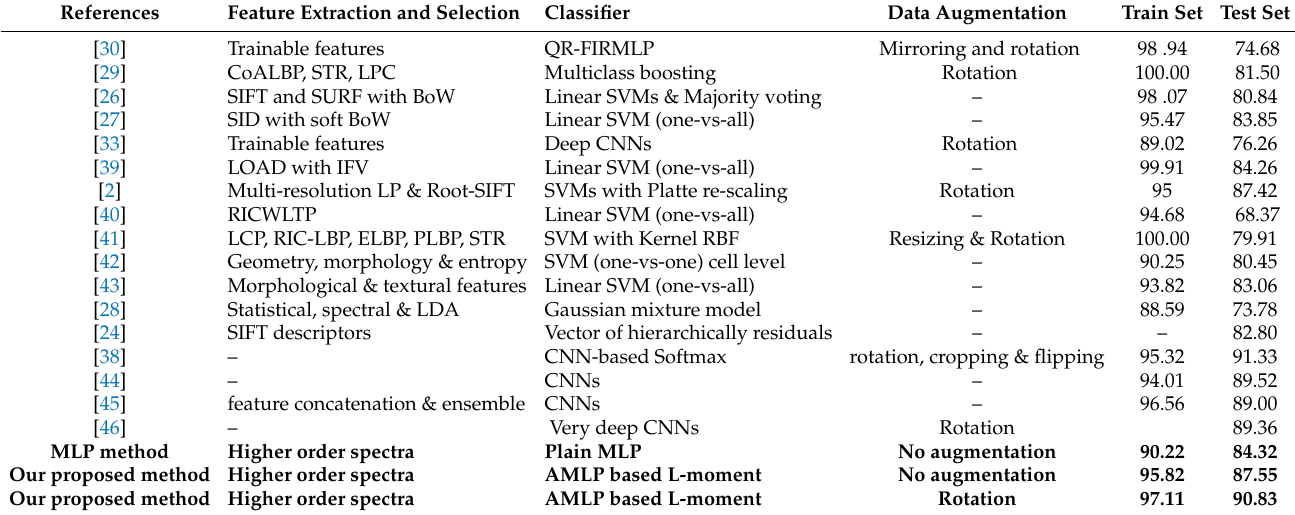
Table 2. Results were achieved by the participants compared in terms of MCA to the recent methods, ICPR2014 and ICPR2016 contests (the first sixteenth rows of the table) and our adapted (MLP) classifier (the remaining rows of the table in bold text) over Task-1 training